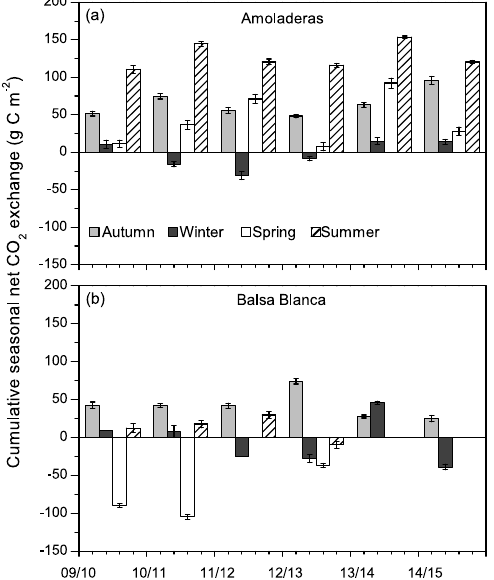
Figure 4. Cumulative seasonal net CO 2 exchange over the study period in both experimental sites. Negative values denote net carbon uptake, while positive values denote net carbon release. In the case of Balsa Blanca, missing bars correspond to long-term data losses ( > 50%